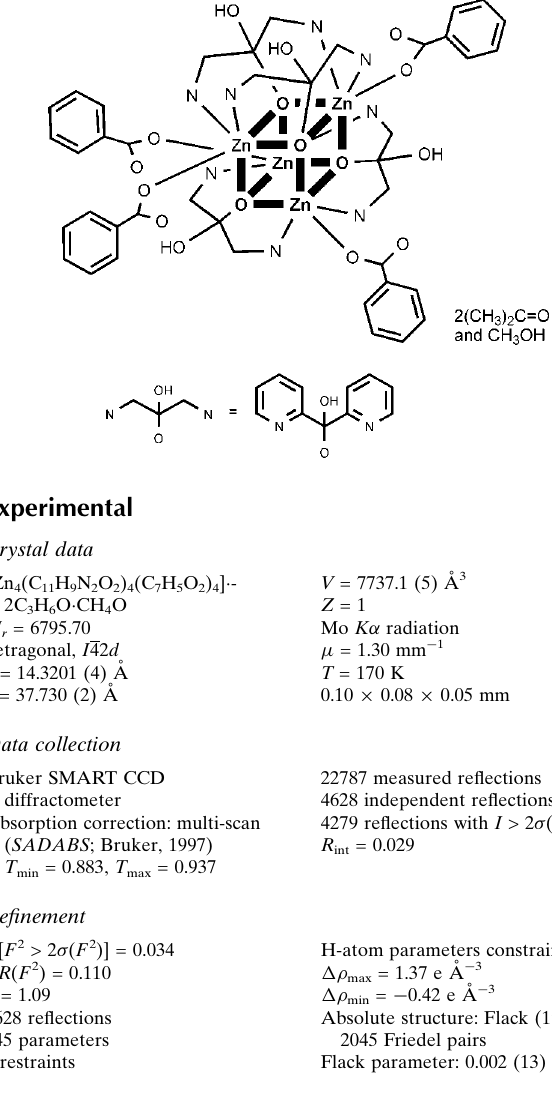
Data collection Bruker SMART CCD diffractometer